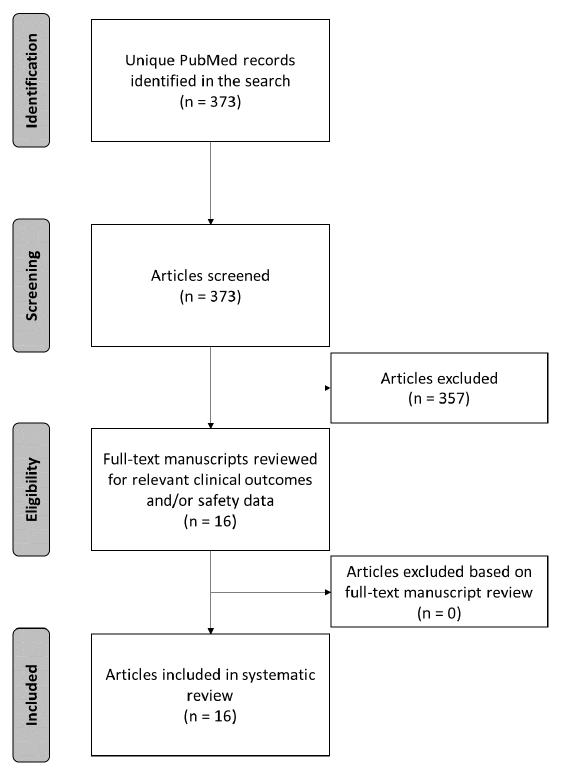
Figure 1. Study flow diagram.